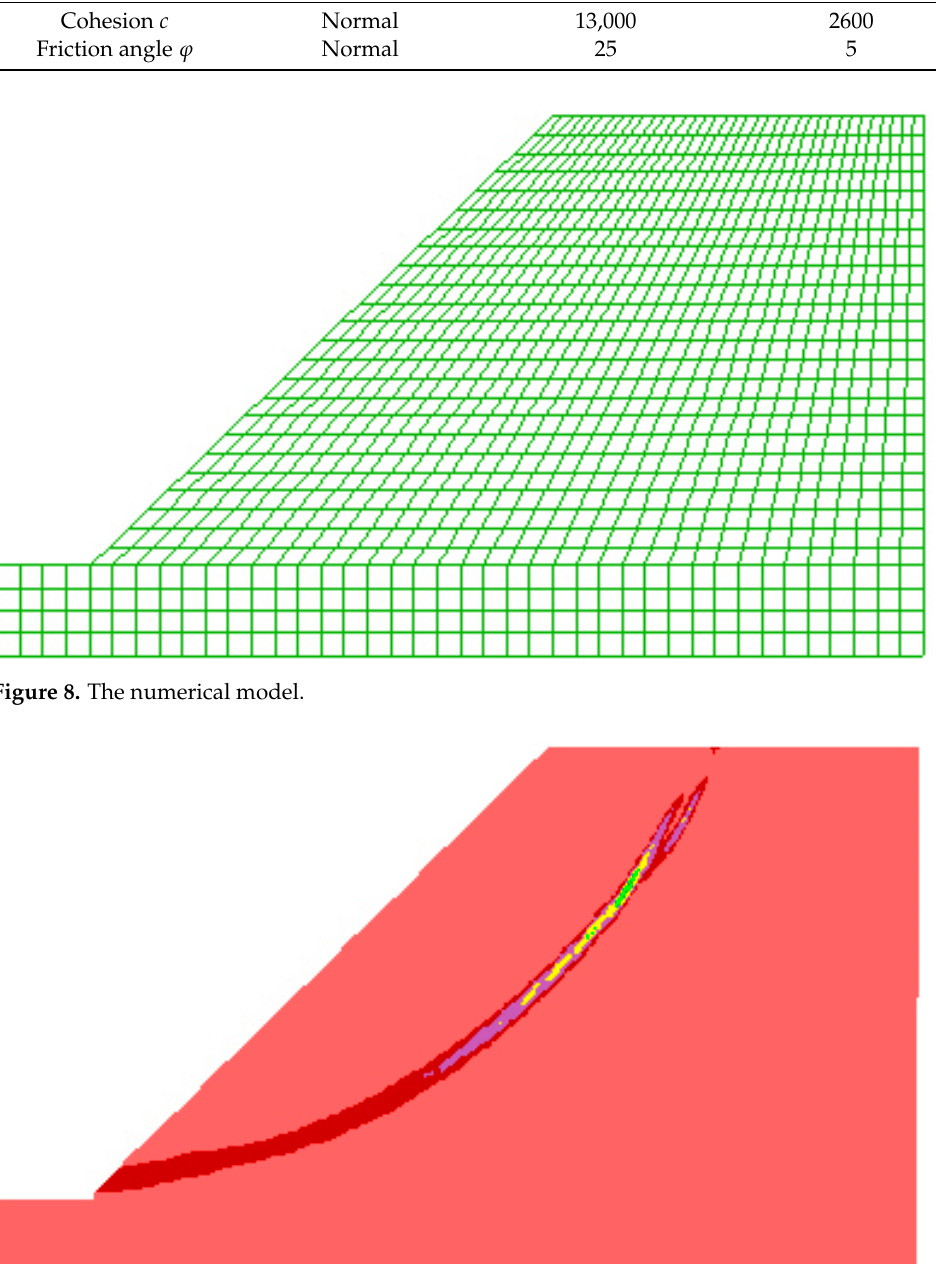
Table 8. The statistical parameter of soil strength for soil slope.